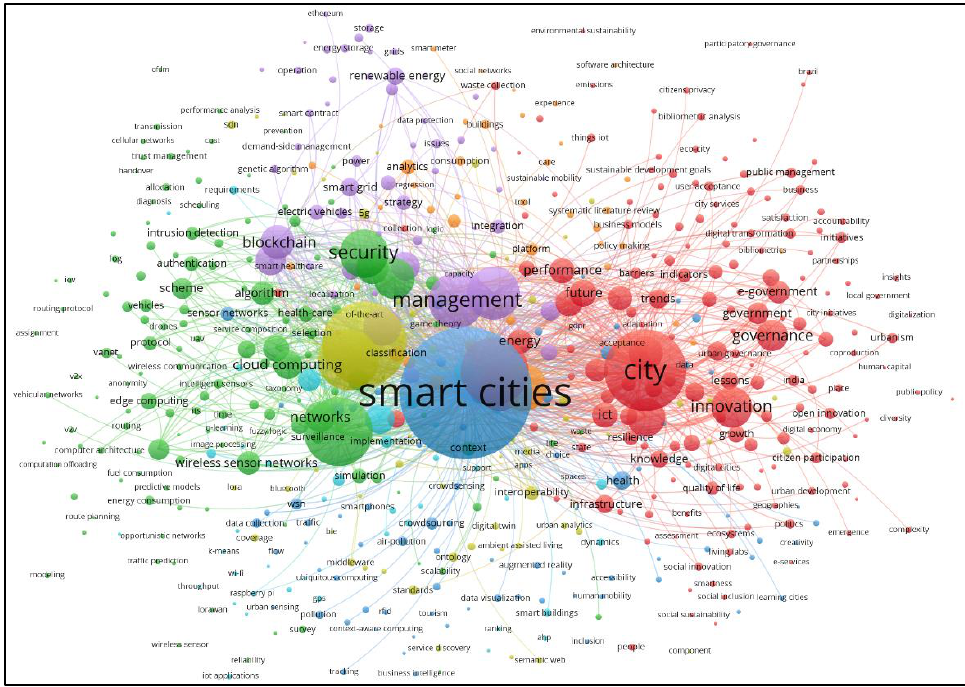
Figure 6. Bibliometric analysis of keywords dealing with the topic Smart cities. Source: own analysis as per Web of Science (2022).